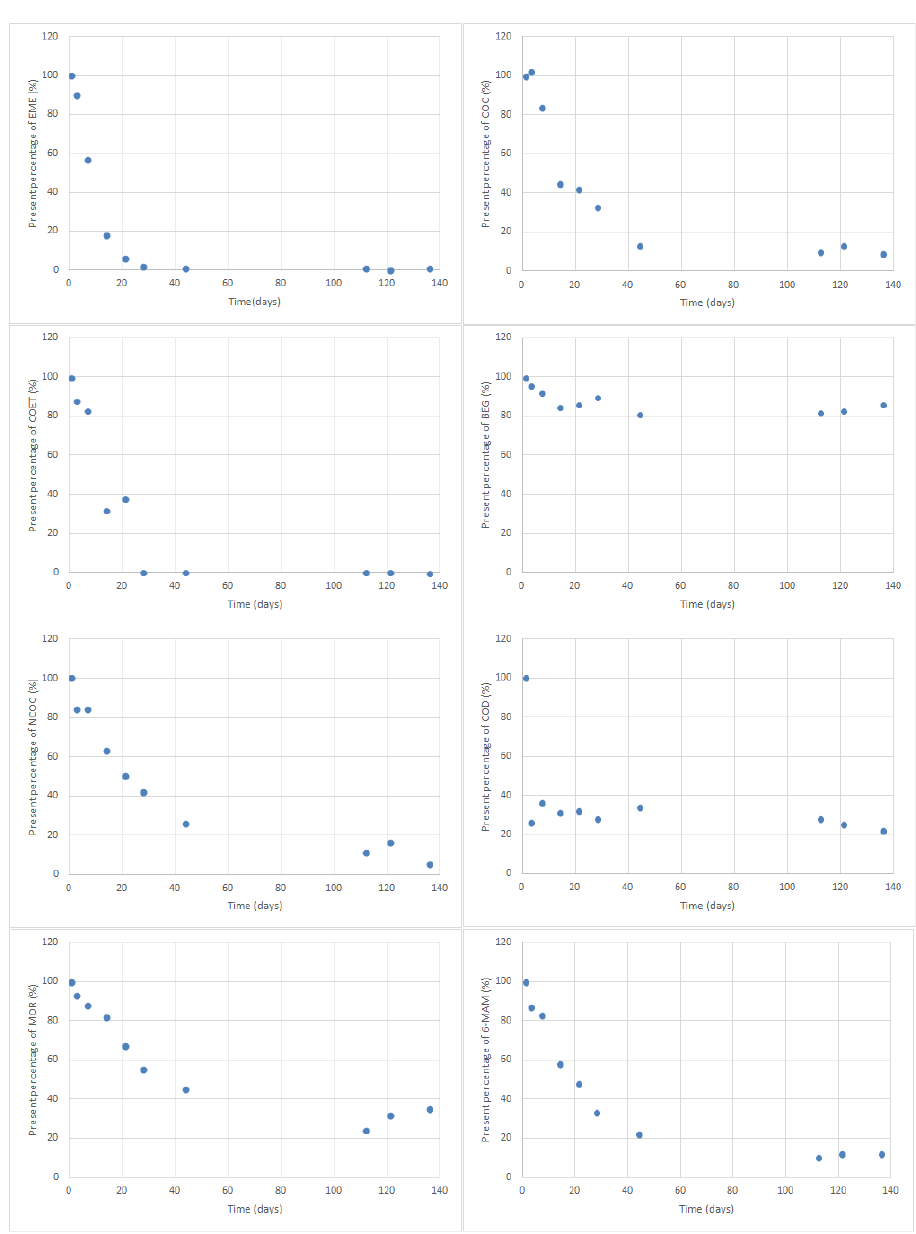
Figure 6. Long-term stability of analytes under study. The graphs represent the percentage of the compounds in the DSS samples as a function of time.